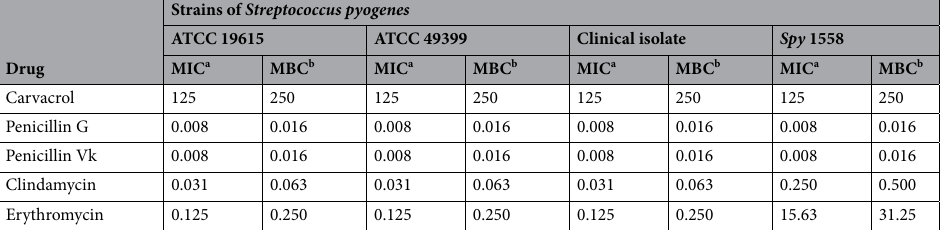
Table 1. Minimum inhibitory concentration (MIC) and minimum bactericidal concentration (MBC) (μg/ mL) of carvacrol against four strains of Streptococcus pyogenes . Data are representative of three independent experiments. a Minimum inhibitory concentration (MIC) was determined as the lowest concentration of tested compound that inhibited bacterial growth. b Minimum bactericidal concentration (MBC) was determined as the lowest concentration of tested compound that killed at least 99.9% of the initial inoculums.